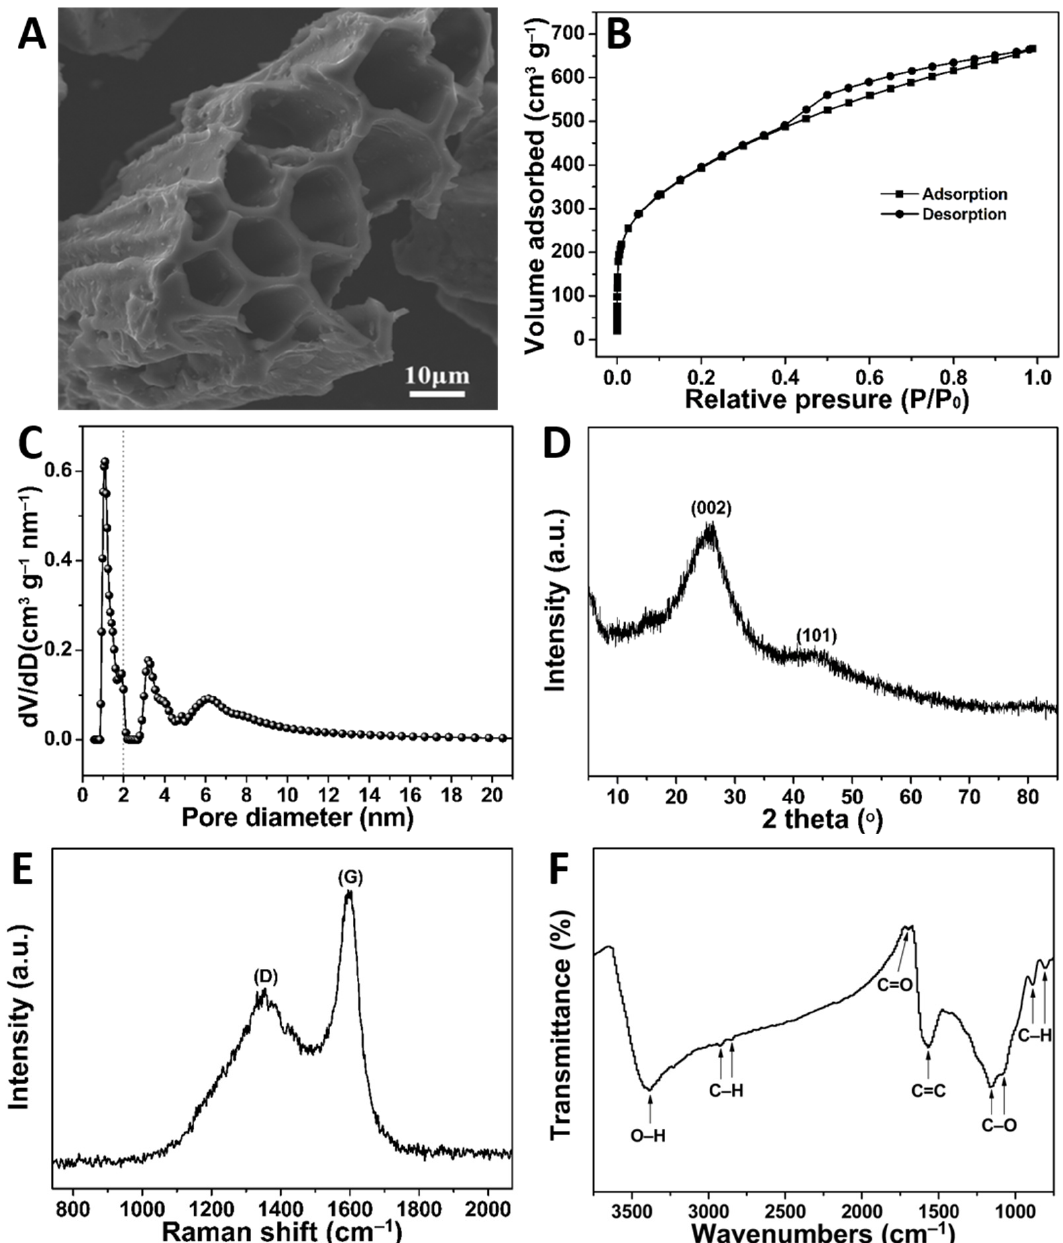
Figure 2. ( A ) SEM image, ( B ) nitrogen adsorption–desorption isotherm, ( C ) DFT pore size distribution curve, ( D ) XRD pattern, ( E ) Raman spectrum, and ( F ) FTIR spectrum of SPVPC.